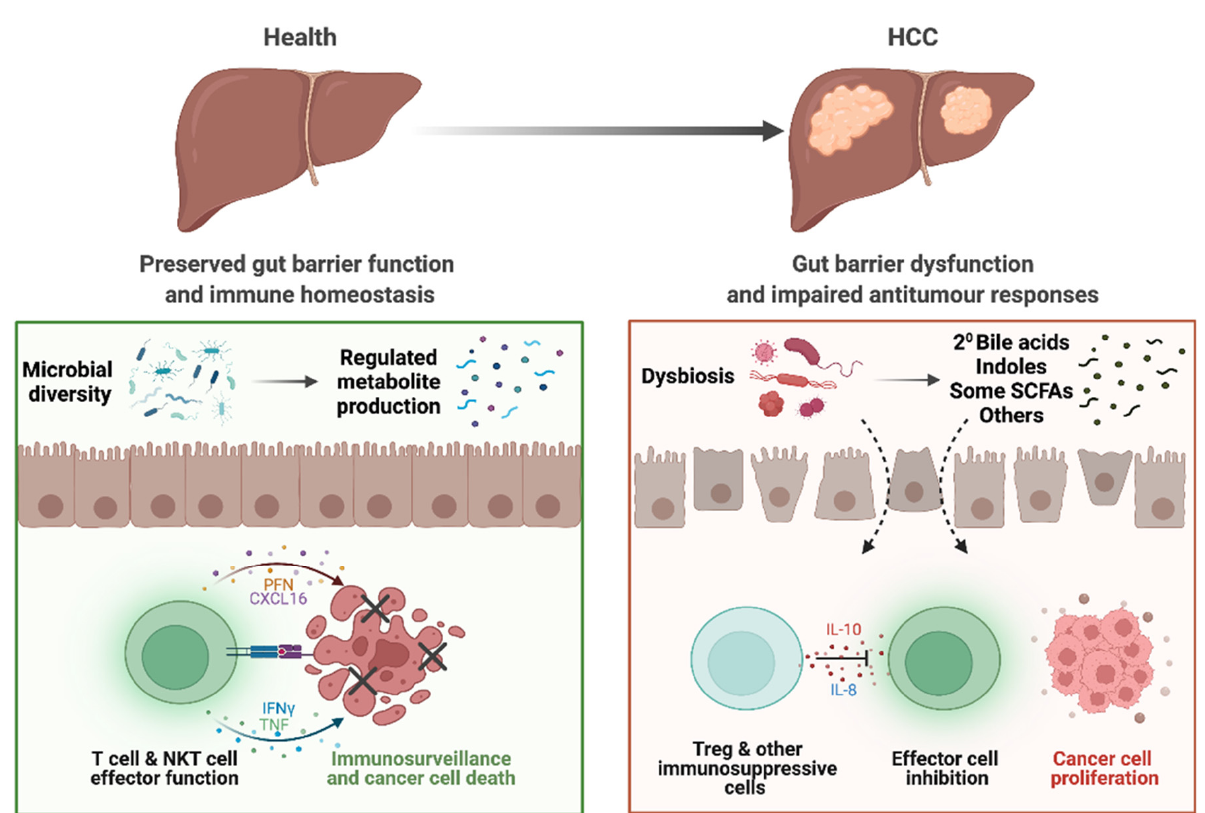
Figure 1. Altered gut–liver axis in patients with HCC. In health, the gut microbiota and bacterial metabolites produced maintain homeostasis of the gut. Preserved gut barrier functions prevent bacterial translocation and subsequent inflammation and allows only selected metabolites through into the circulation. Ultimately, homeostasis in the liver is also maintained, with immune surveillance that prevent hepatocarcinogenesis. However, in patients with HCC, dysbiosis results in dysregulated metabolite pool, including increased bile acids (BAs) and dysregulated BA and short-chain fatty acid (SCFA) signalling. There is also impaired gut barrier function, allowing for translocation of bacteria, bacterial components, and metabolites that induces inflammation. In the liver, these factors also play a role in impairing CD8+ T cell antitumour effector functions and increases Treg functions and immunosuppression. Together, these tumorigenic responses may contribute to the initiation and potentiation of HCC.